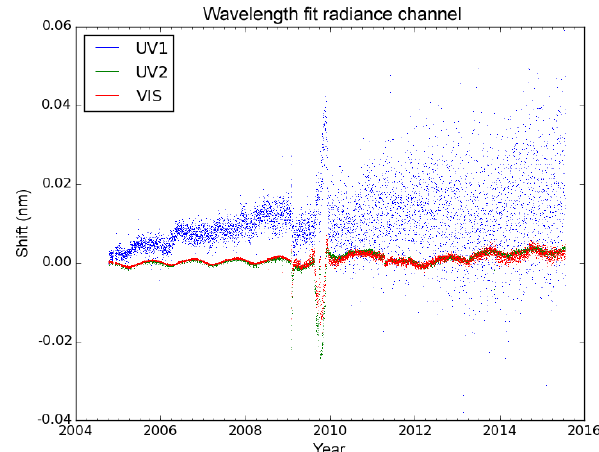
Figure 33. Spectral calibration trend over the mission for the radi- ance channel. Spectral calibration for the UV1 channel is strongly affected by the row-anomaly effect since 2009. Table 6. Solar signal changes observed in the three channels for the timeframe 2005–2015.